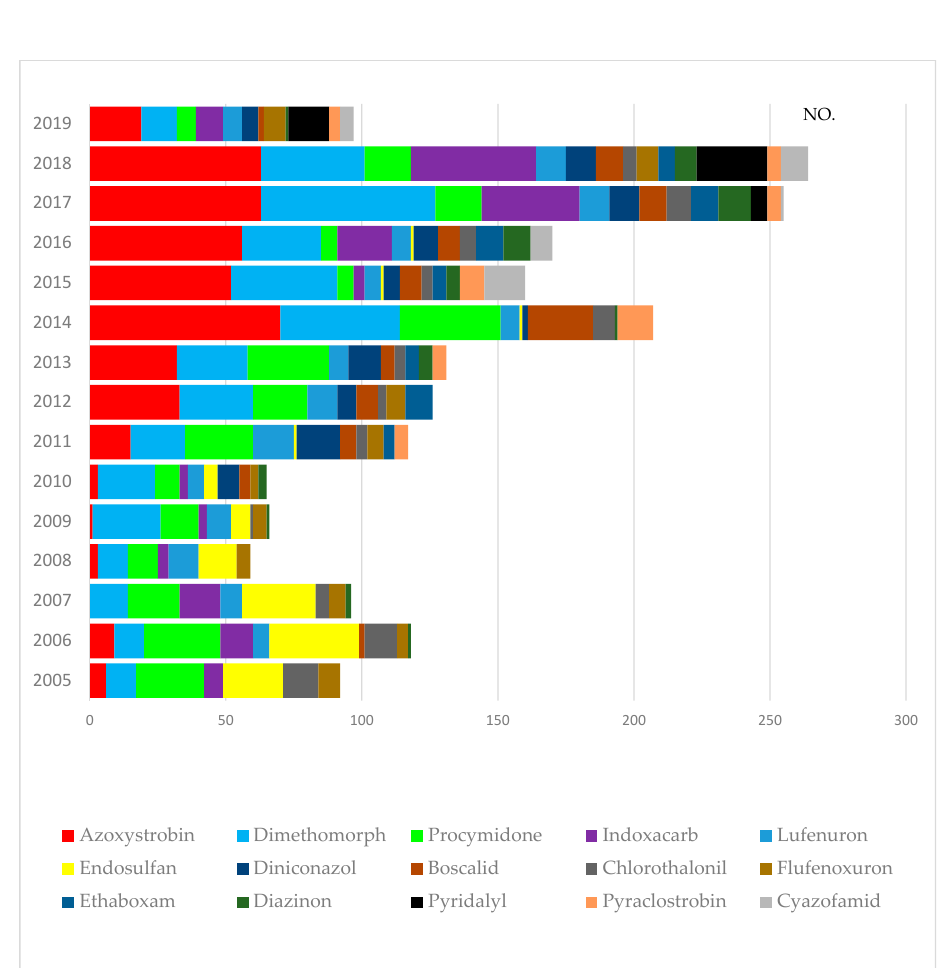
Figure 2. Distribution of pesticide residues (<MRLs) from 2005 to 2019: the 15 pesticides most frequently detected in the samples analyzed.